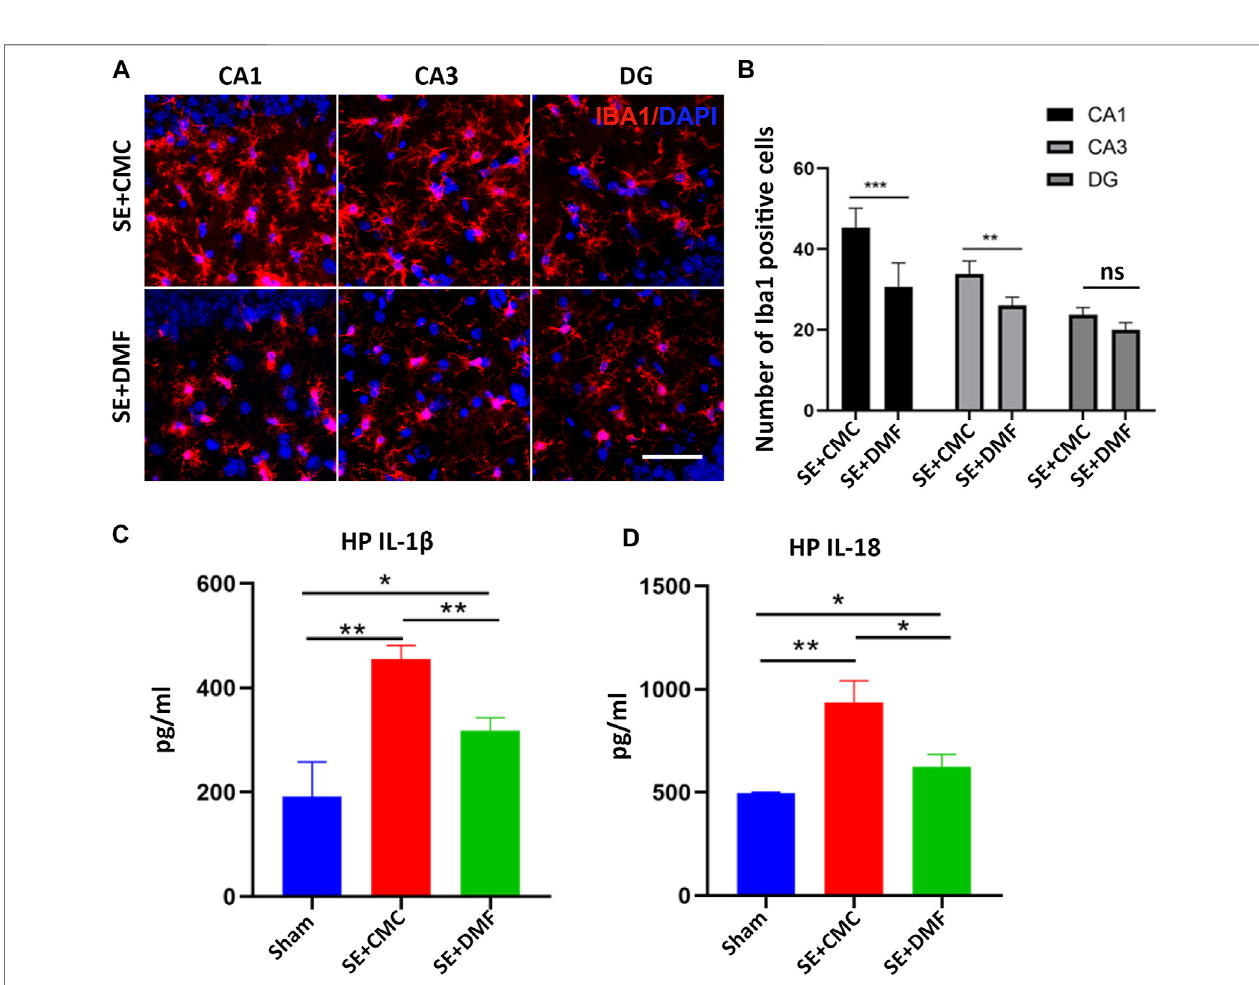
FIGURE4| DMFinterventioninhibitedtheactivationofmicrogliaandtheexpressionofin fl ammatoryfactors. (A) MicrophotographsofIba1(red)stainingintheCA1, CA3, and DG regions ofthe hippocampus in the SE+ CMC and SE + DMF groups. (B) Statistical analyses ofthe number of Iba1-positive cells in the CA1, CA3, and DG regions in the SE + CMC and SE + DMF groups. (C) Relative expression of IL-1 β in the ipsilateral hippocampus based on ELISA. (D) Relative expression of IL-18 in the ipsilateral hippocampus based on ELISA. (n (cid:1) 3 in each group, * p < 0.05, ** p < 0.01, and *** p < 0.001).